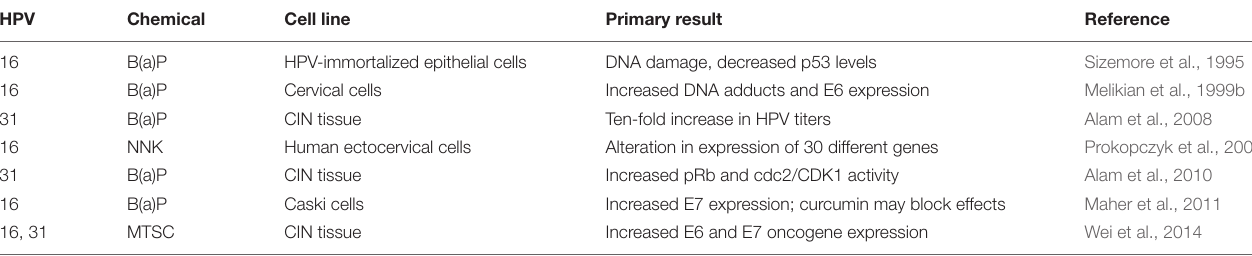
TABLE 1 | Co-carcinogenesis: in vitro studies of HPV-chemical